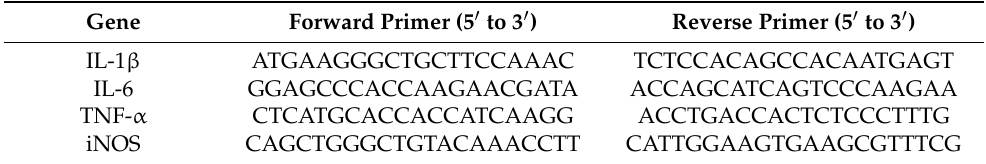
Table 1. Primer sequences used for real-time polymerase chain reaction (PCR).